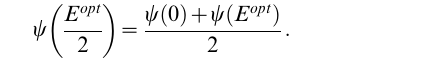
Þ = 2 . The resulting fits are shown in Figure 4. The values of y min and y max were typically close to